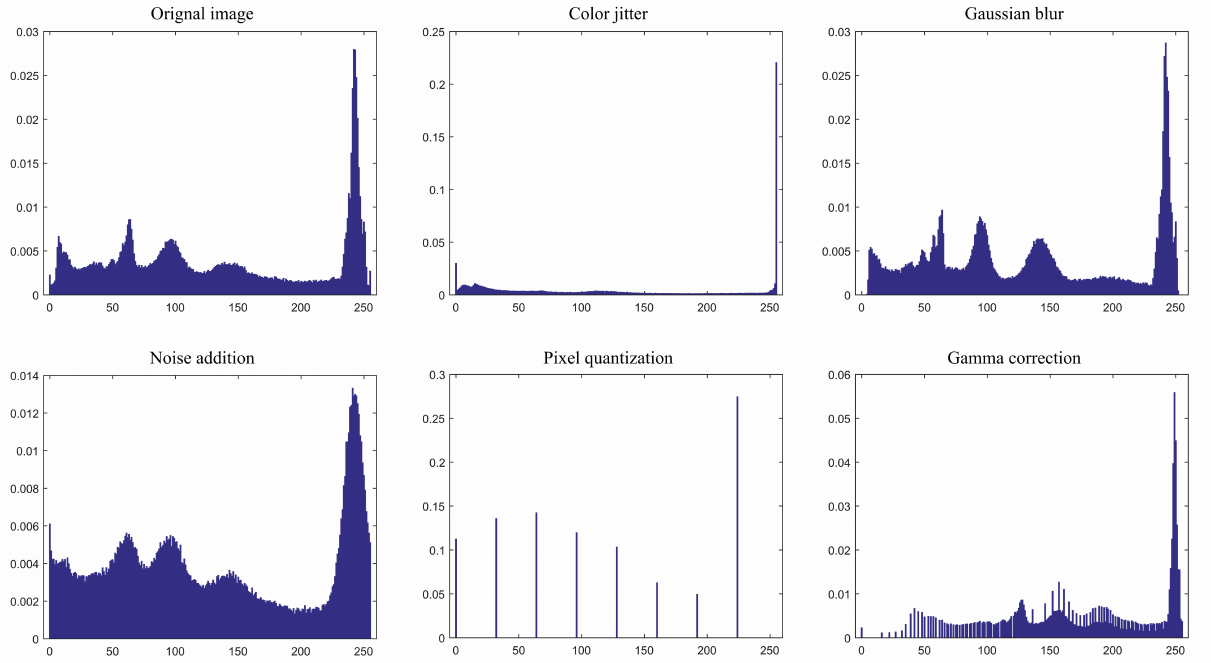
Figure 3. Normalized histogram of pixel values of the green channel of the six images in Figure 2. In each sub-figure, the horizontal axis represents the pixel value (between 0 and 255) and the vertical axis represents normalized occurrence. Please notice that the range of the vertical axis is not always the same for the six sub-figures.